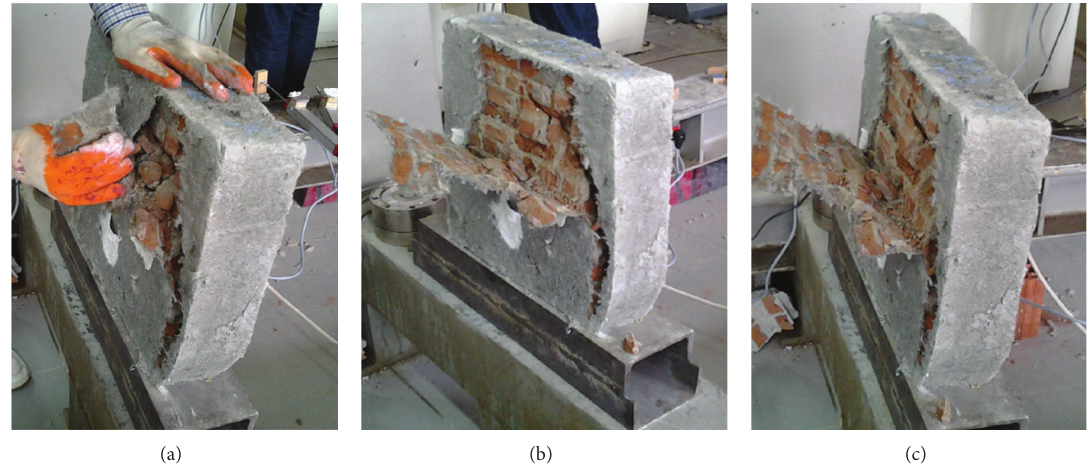
Figure 12: The polypropylene fiber plaster sample failure.